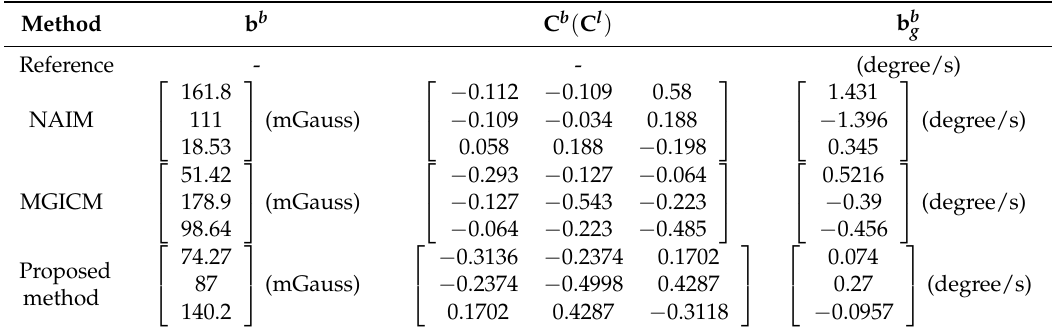
Table 5. Calibration results.